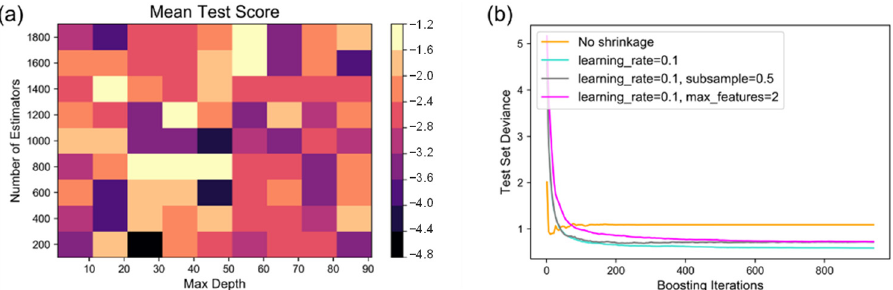
Figure 4. ( a ) GBRT parametric grid search result. Note that the mean test score is the negative mean squared error. ( b ) Effect of shrinkage and subsampling on the goodness-of-fit of the GBRT model. The abscissa is the number of boosting iterations, and the ordinate is the deviation of the test set. All six models were firstly trained with default parameter data, and the results of the five-fold cross-validation are shown in Table 3, including the resultant R 2 , EV , MAE , and RMSE for the validating and testing processes. All the urban form indicators and natural